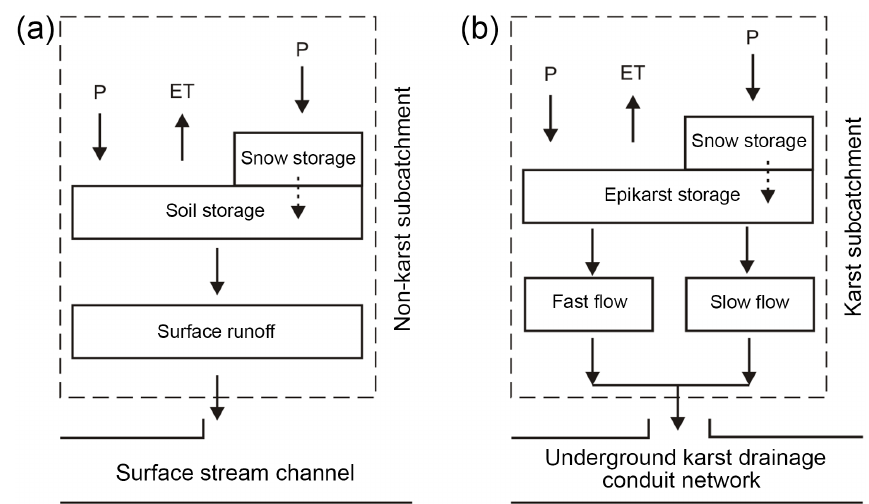
Figure 2. (a) Model concept for the subcatchments in the non-karst area and (b) model concept for the subcatchments in the karst